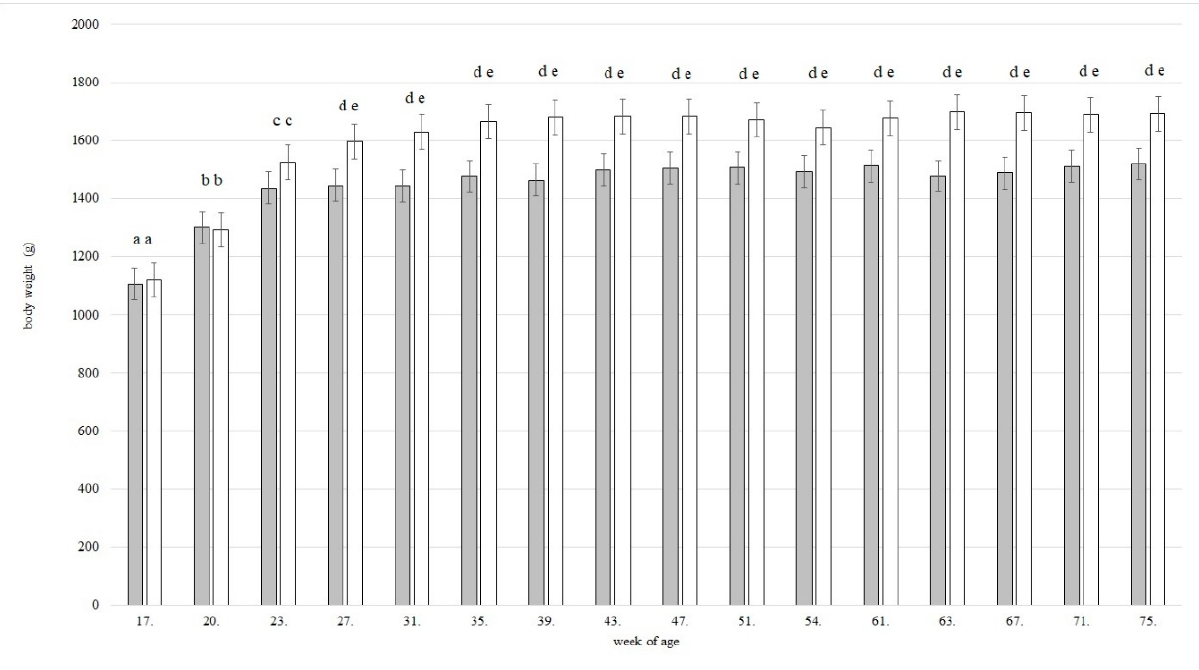
Figure 3. Development of body weight during the whole study ( n = 7 laying hens in single cages, grey bars; n = 6 laying hens in floor pens, white bars). Figure shows means of least squares plus/minus standard error. Lowercase letters indicate significant differences ( p < 0.05).